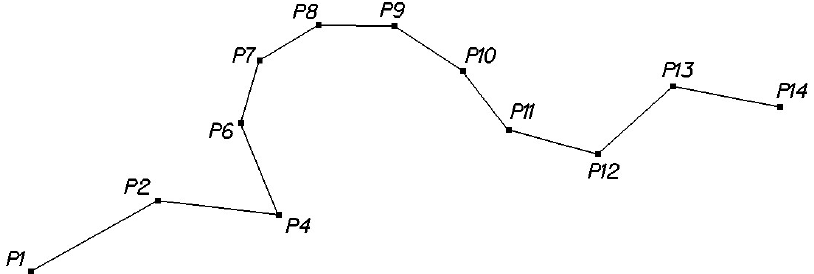
Figure 2. The result of the first stage of generalization.